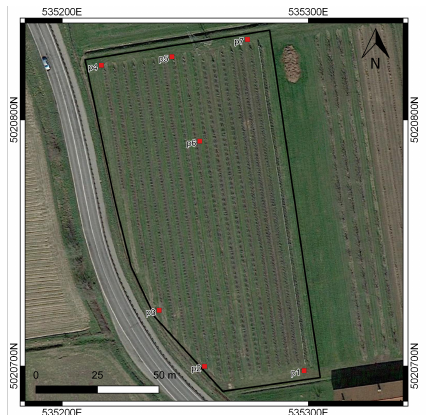
Figure 4. Ground Control Points’ (GCPs) distribution for the surveys on the pear orchard. Map data: c (cid:13) Google Satellite.